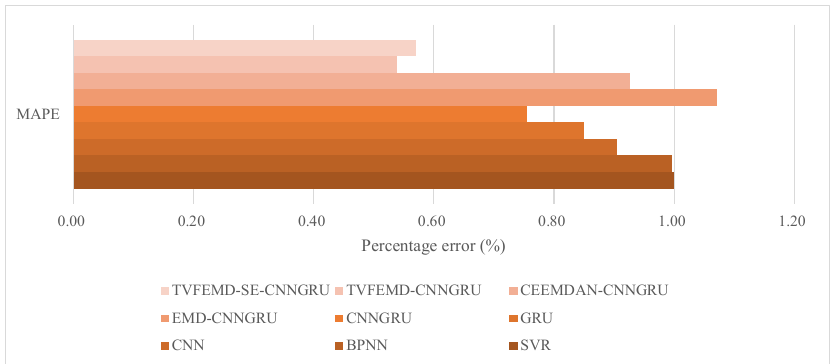
Figure 10. Histogram of metric MAPE .